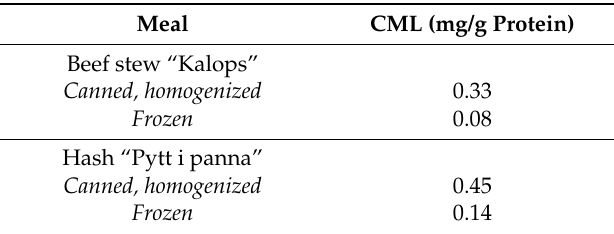
Table 1. N -carboxymethyl-lysine (CML) content in canned and homogenized meals intended for